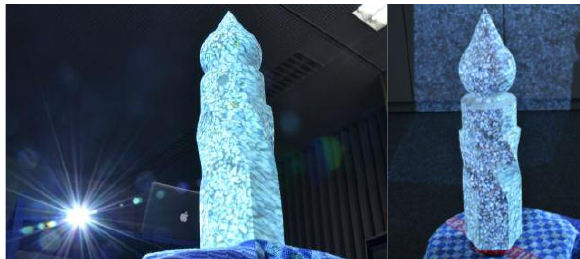
Figure 10: Photogrammetric acquisition of the white test object “Testy” using artificial texture from 3 video projectors. In order to acquire a point cloud of the white object, 3 video projectors were used to project texture from all directions. Subsequently, 46 images were acquired using a Nikon D7000 DSLR in a circular shape around the object. The interior and exterior orientation was determined automatically using the software VisualSFM [Wu, 2011] without prior calibration. The orientations were used within the dense image matching solution SURE to derive a dense point cloud. The scale for the resulting point cloud of about 80 Mio. points was estimated using a best-fit cylinder in the cylinder shaped part of both point clouds. The transformation to the reference object was determined using the Iterative Closest Points algorithm [Besl & MacKay, 1992].